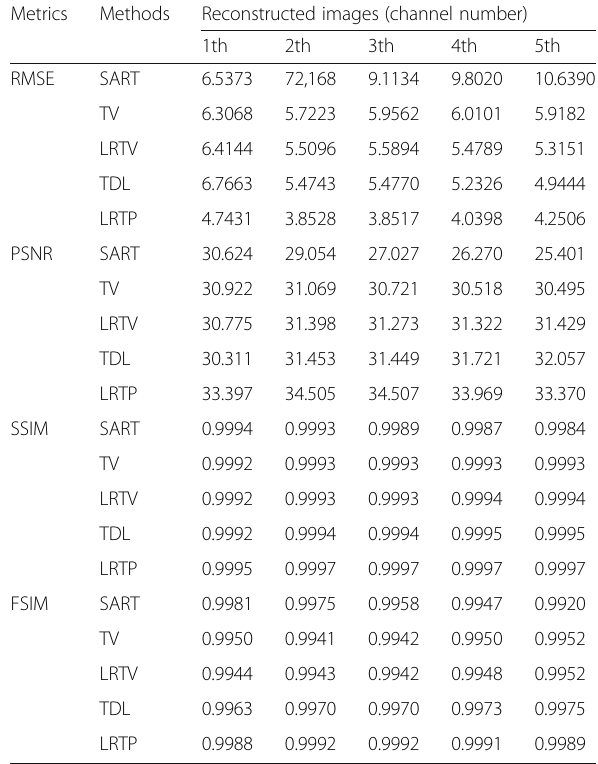
Table 3 RMSE (10e-4), PSNR, SSIM, FSIM Index for region of interest images in Fig. 7 Metrics Methods